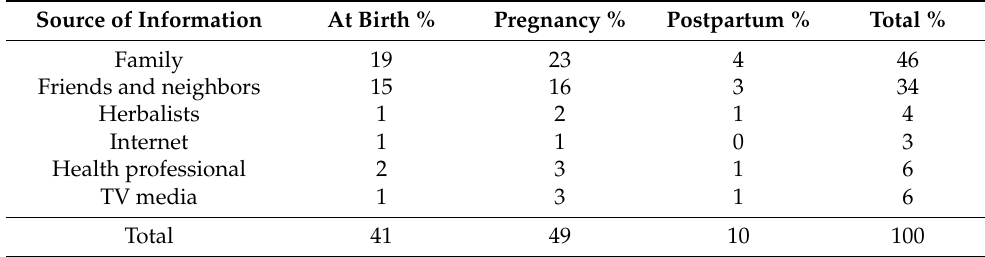
Table 6. Top sources of herbal medicine